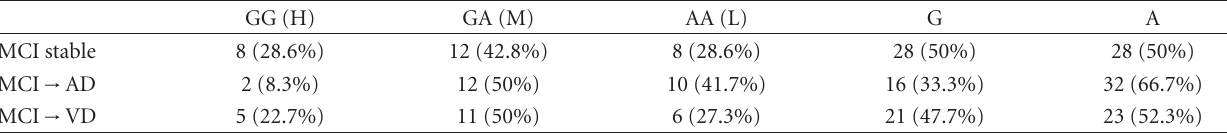
Table 3: Distribution of genotype and allele frequencies of − 1082 (G/A) SNP in MCIs that remain stable, progressed to AD (MCI → AD), and progressed to VD (MCI →